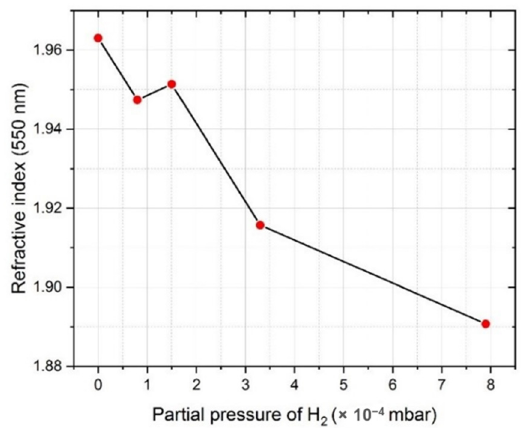
Figure 3. Refractive index of hydrogenated silicon nitride (SiN x :H) thin films at a wavelength of 550 nm as a function of H 2 partial pressure.